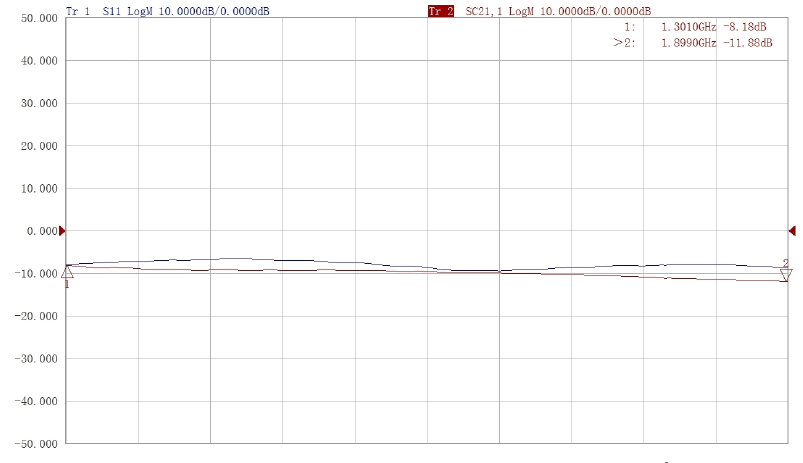
Figure 13. Down-conversion loss of mixer 2.